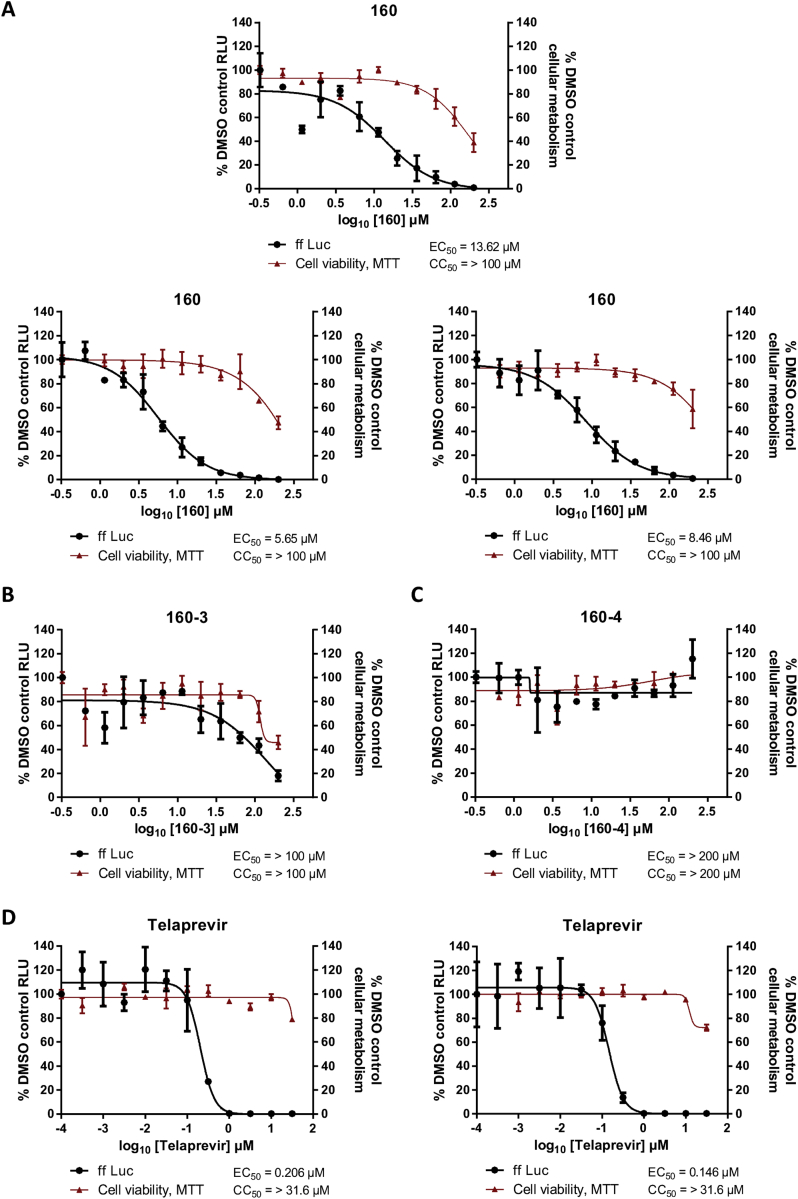
Activity of 160 and analogues against NS2-dependent genome replication. SGR-luc-NS2-5B(JFH-1) RNA was electroporated into Huh7.5 cells which were treated with indicated concentrations of 160 (A) or the inactive derivatives 160-3 (B) or 160-4 (C) at 4 h.p.e. At 48 h.p.e cell viability was quantified by MTT assay and luciferase activity was measured and plotted relative to DMSO control. Data represent the mean ± SD of individual experiments performed in duplicate. (D) As a control the NS3 protease inhibitor Telaprevir was used in the same assay.